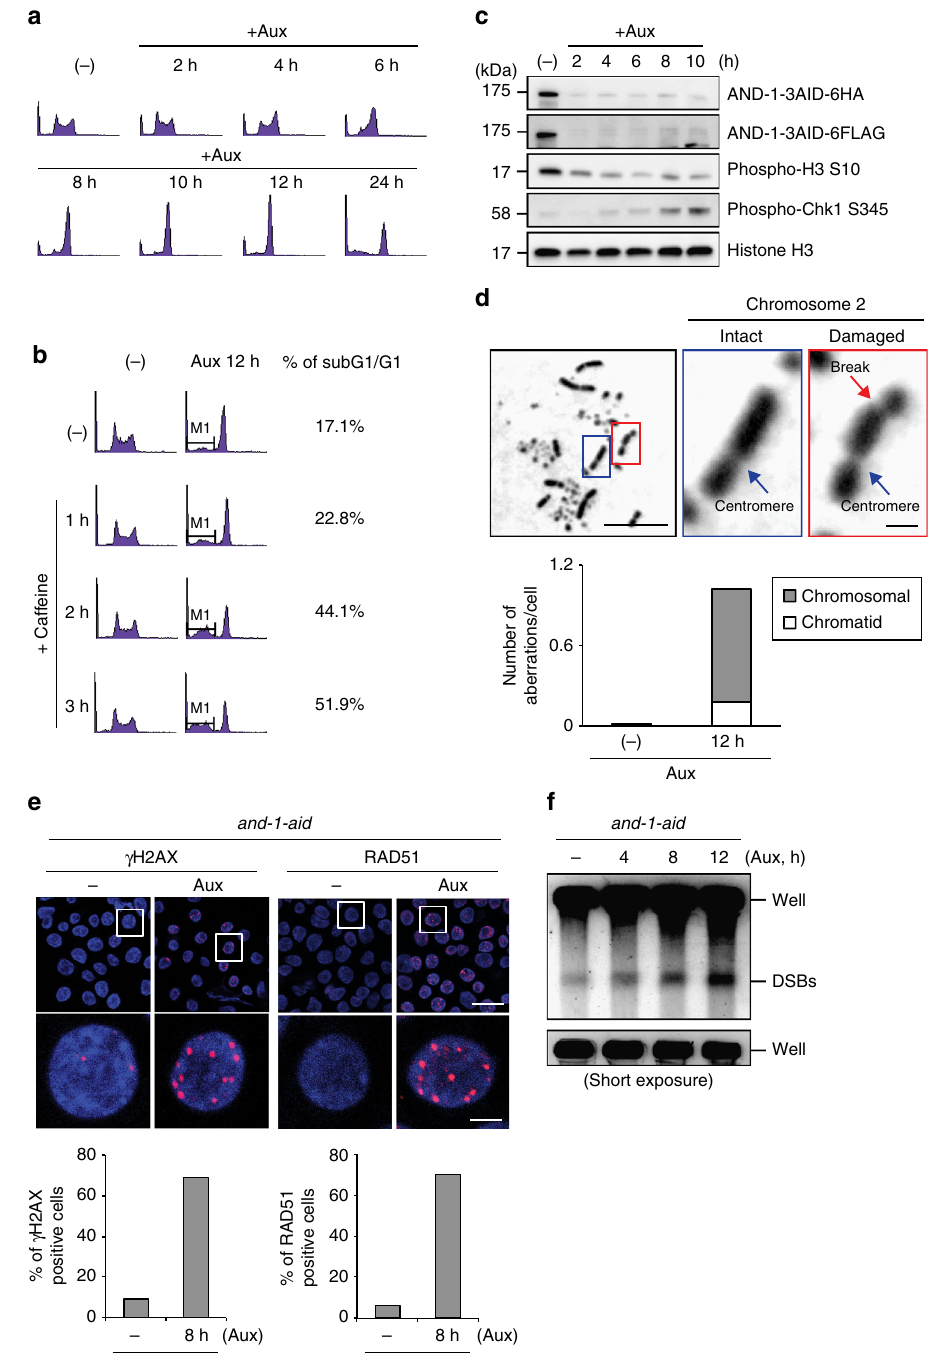
Fig. 2 AND-1 depleted DT40 cells display spontaneous accumulation of DNA double strand breaks (DSBs) and DNA damage checkpoint activation. a Cell cycle distribution of AND-1 depleted cells. and-1-aid cells were incubated with auxin for indicated times, stained with propidium iodide (PI), and DNA content was analyzed by fl ow cytometry. b and-1-aid cells were incubated with or without auxin for 12 h, caffeine was added, and further incubated for the indicated times. DNA content was analyzed by fl ow cytometry. c Total cell lysates were prepared from and-1-aid cells at the indicated time points and analyzed by Western blotting. d and-1-aid cells were incubated with or without Auxin for 12 h, caffeine and colcemid were added, and further incubated